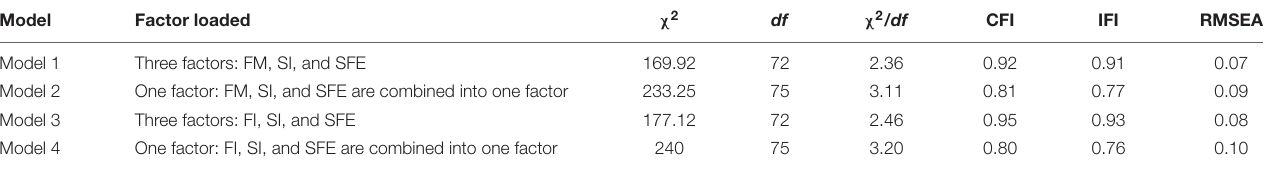
TABLE 1 | Confirmatory factor analysis of discrimination validity. Model